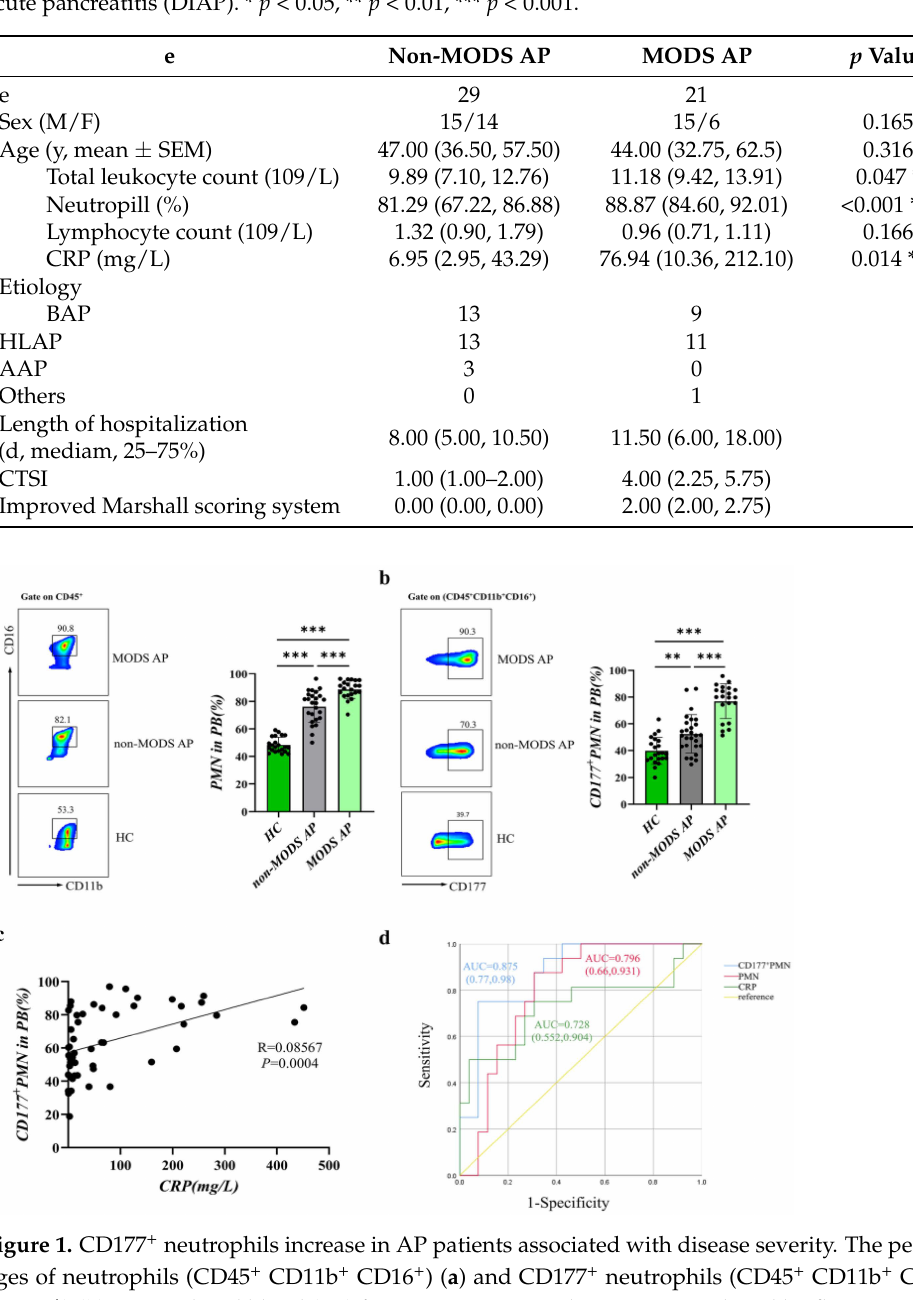
Table 1. Demographic data and clinical characteristics of AP patients with or without MODS. Data are described as median (P25, P75) or n (%). MODS, multiple organ dysfunction syndrome; AAP, alcohol- induced AP; BAP, biliary AP; HLAP, hyperlipidemic AP; CTSI, computed tomography severity index; F, female; M, male; CRP, C-reactive protein. Others include idiopathic AP (IAP) and drug-induced acute pancreatitis (DIAP). * p < 0.05, ** p < 0.01, *** p < 0.001.